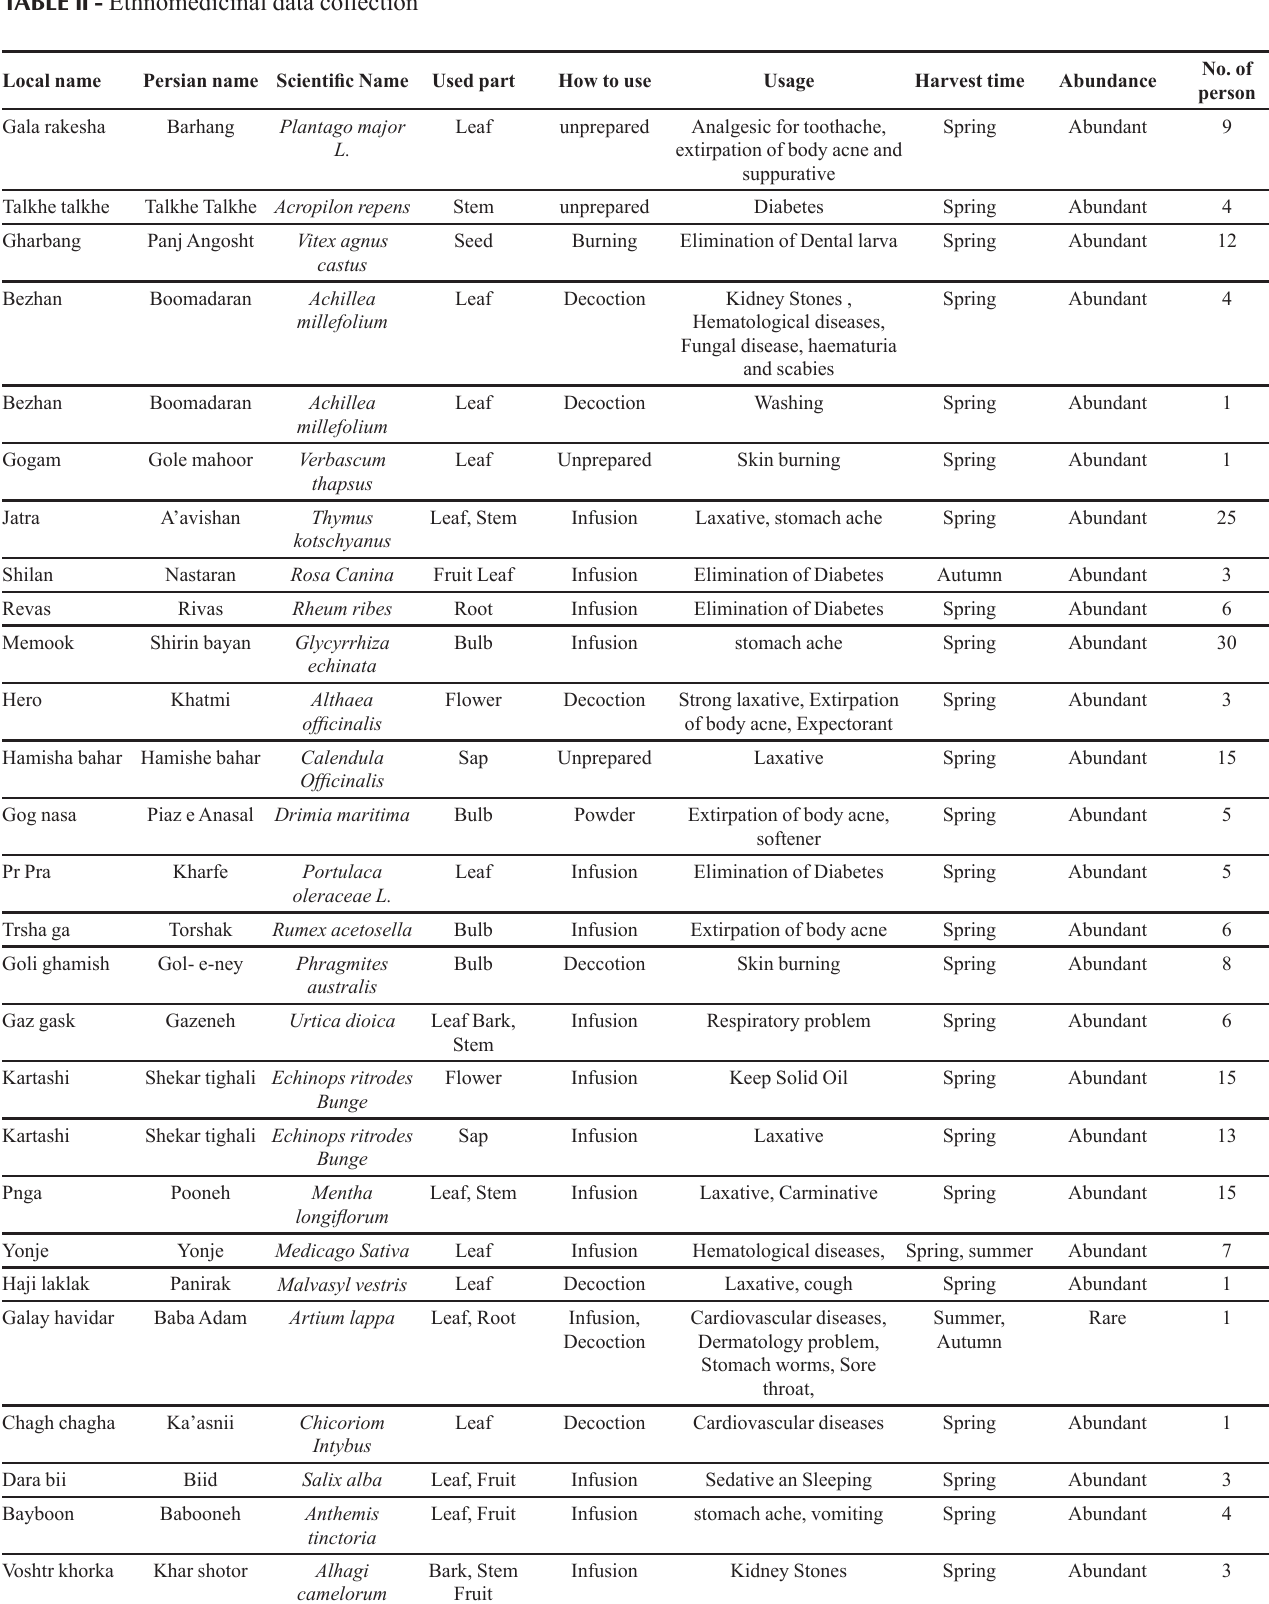
TABLE II - Ethnomedicinal data collection Local